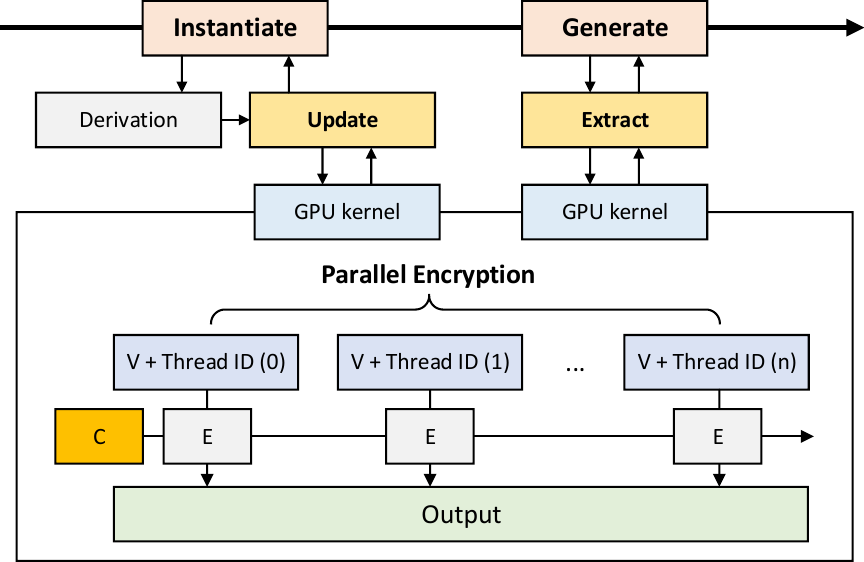
Figure 17. Parallel CTR_DRBG optimization on